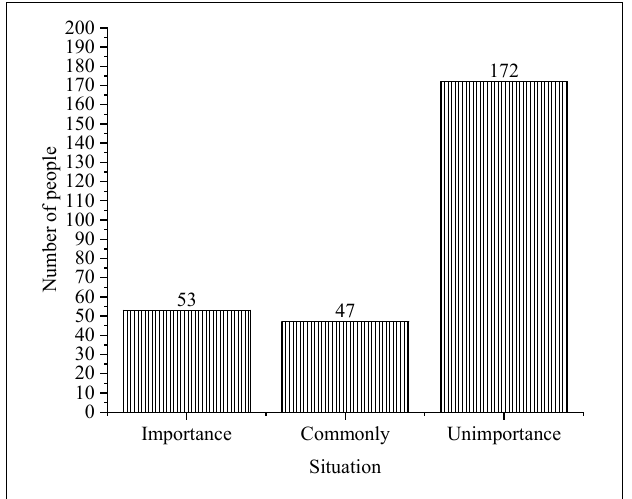
FIGURE 10 | Teacher’s emphasis on western